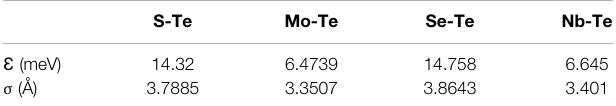
TABLE 1 | LJ parameters for graphene/MoS 2 and graphene/NbSe 2 systems. S-C Mo-C Se-C Nb-C Ɛ (meV)